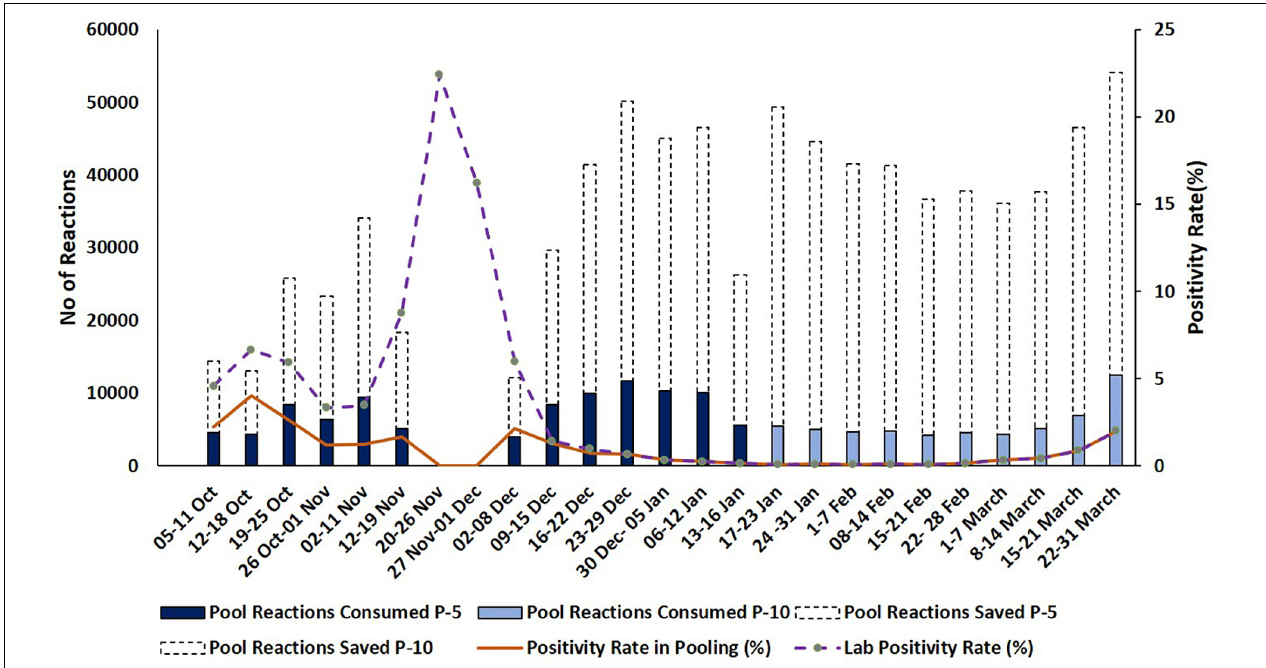
FIGURE 4 | Representation of resources consumed and saved during pooling strategies. Dash type trend line and dark color trend line indicate the percentage of lab positivity and the positivity rate in pooling during the testing period, respectively. Y -axis indicates reactions saved in numbers and positivity rate in